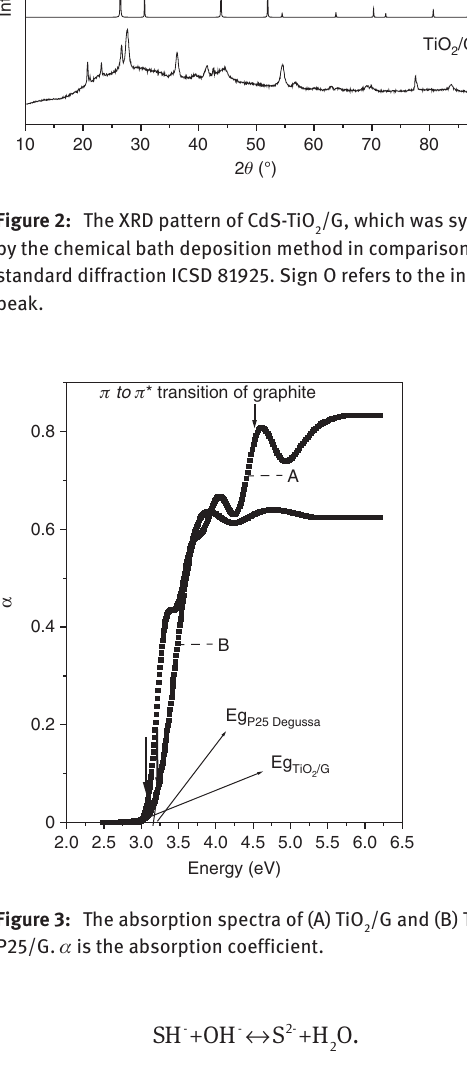
Figure 3: The absorption spectra of (A) TiO P25/G. α is the absorption coefficient.